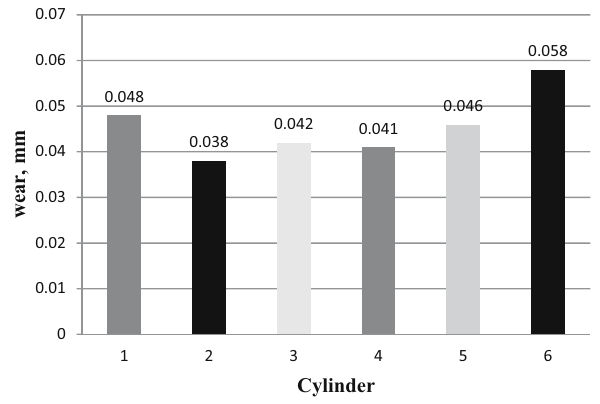
Figure 2: Average wear of cylinder liners after 750 starts.